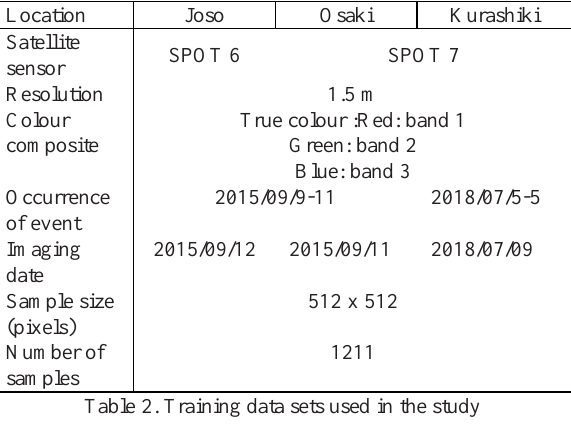
Figure 3. Location Map of training and test data sets. Training data sets bounded by yellow boxes © SPOT image AIRBUS DS 2018